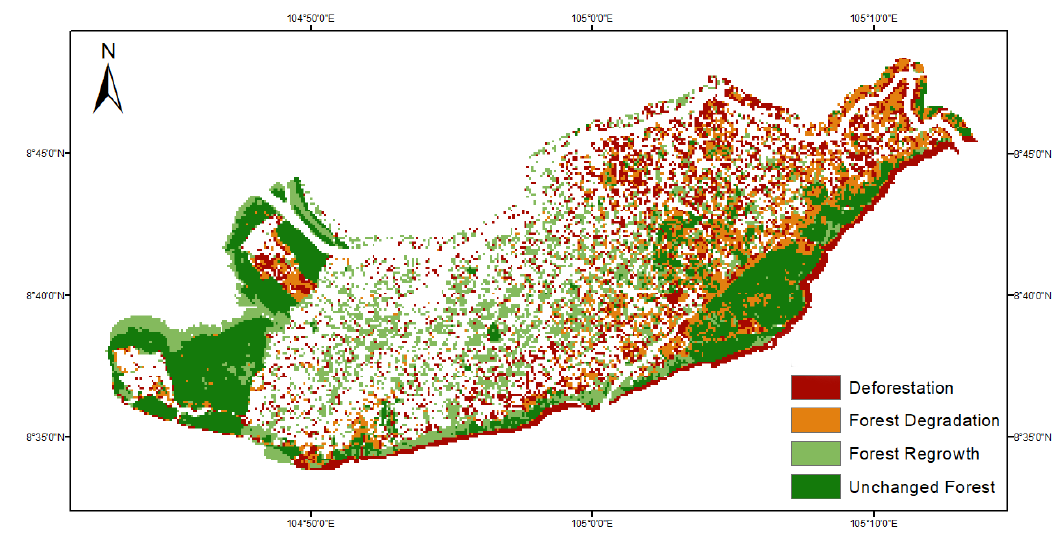
Figure 4. Temporal changes in total land cover surface across four land use classes in Ngoc Hien district. Years with SLC malfunction are shaded in grey considering the higher uncertainties. Remote Sens. 2020 , 12 , x FOR PEER REVIEW